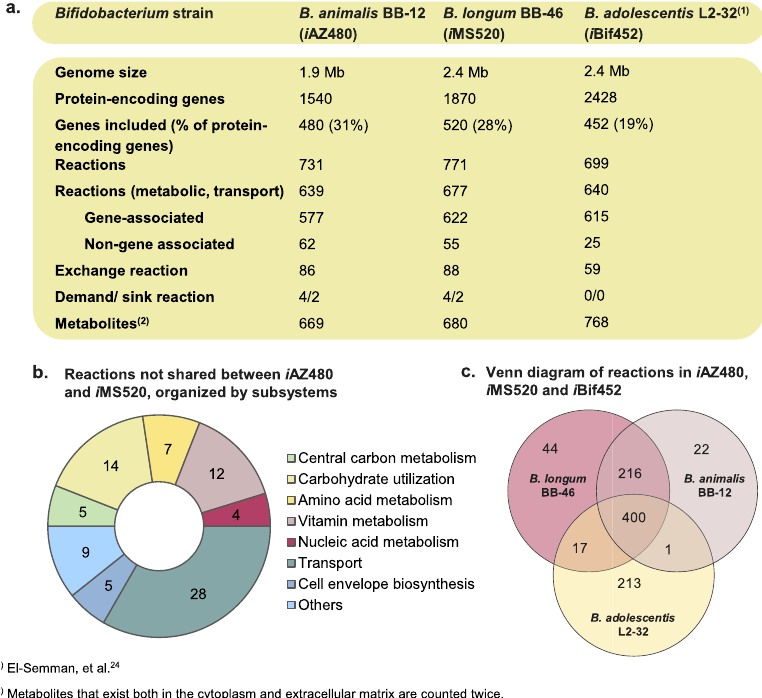
Fig. 2 Comparison of i AZ480, i MS520, and i Bif452. a Main characteristics of the metabolic networks of i AZ480 and i MS520 and i Bif452. b Overview of unique reactions in i AZ480 and i MS520, which exist only in one of the models but not in the other. c A Venn diagram representing the reactions included in i AZ480, i MS520, and i Bif452. The comparison was performed based on BiGG reaction identi fi ers and EC